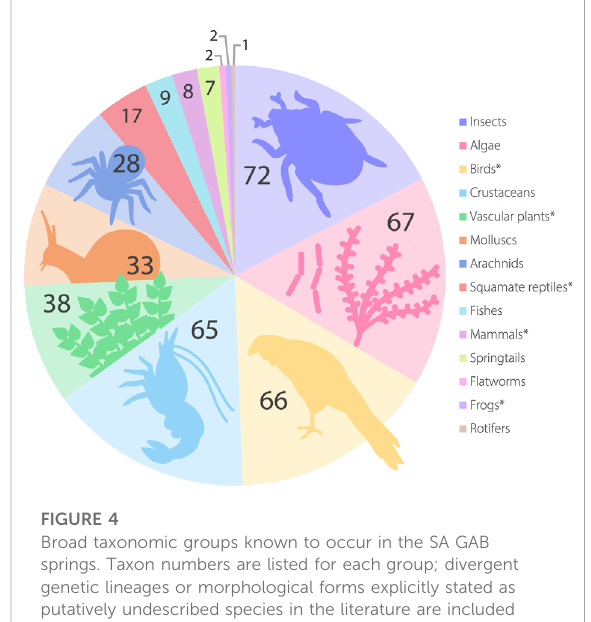
FIGURE 4 Broad taxonomic groups known to occur in the SA GAB springs. Taxon numbers are listed for each group; divergent genetic lineages or morphological forms explicitly stated as putatively undescribed species in the literature are included as separate taxa following Rossini et al. (2018). A full summary of the taxa detailed here is supplied in the electronic supplementary material. Here, algae refer to a paraphyletic grouping including both micro-algae and fi lamentous algae (see text). *Group is not known to contain representatives endemic to SA GAB